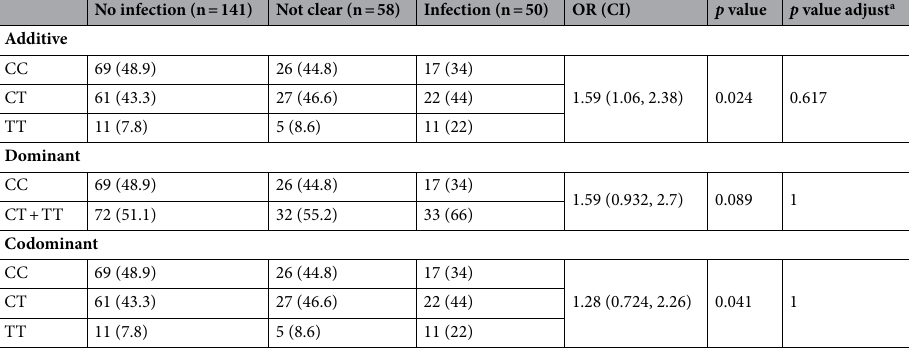
Table 4. Association of SARS-CoV-2 Infection and CLOCK rs3749474 genotype according to genetic models. a Adjusted by sex, age, risk factors, risk of virus exposure, severity, tobacco consumption and arterial hypertension; Corrected by multiple SNP comparisons (26) by Bonferroni test.